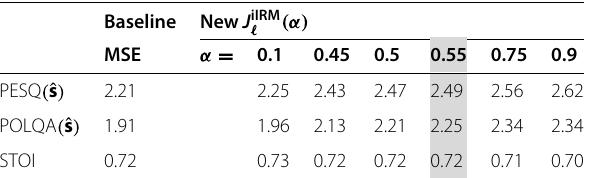
Table 2 Optimization of hyperparameter for the reference iIRM MSE (10) on 12 . 5 % of the validation set . The selected setting is gray-shaded